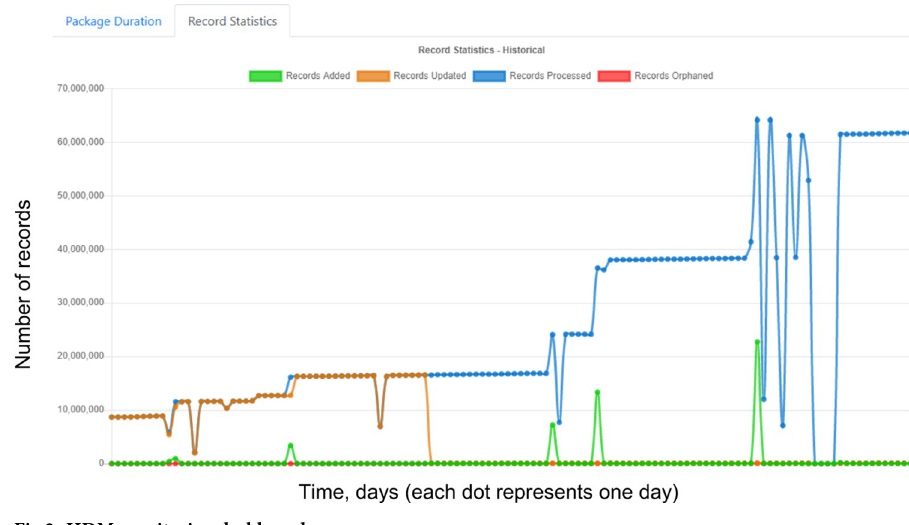
Fig 2. HDM monitoring